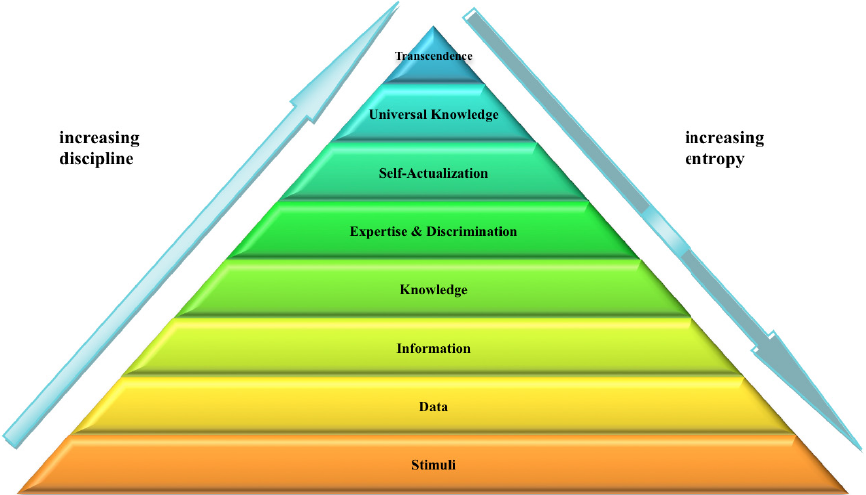
Fig. 1. The Knowledge Pyramid (8 Layer Model). Stimuli (neural representations), Data (recruitment of discrete elements, communication), Information (interconnected data), Knowledge (Acceptance, interest in knowledge, organization of information, theories, axioms), Expertise & Discrimination (applied knowledge, creativity, experience, skills), Self-Actualization (Desire for creativity / innovation, mastering of skills), Uni- versal Knowledge (Unification of laws and theories, conceptualization, prediction of behavior, needs and problems, problem solving) Transcendence (Self-forgetfulness, loss of self-consciousness, transcendence of